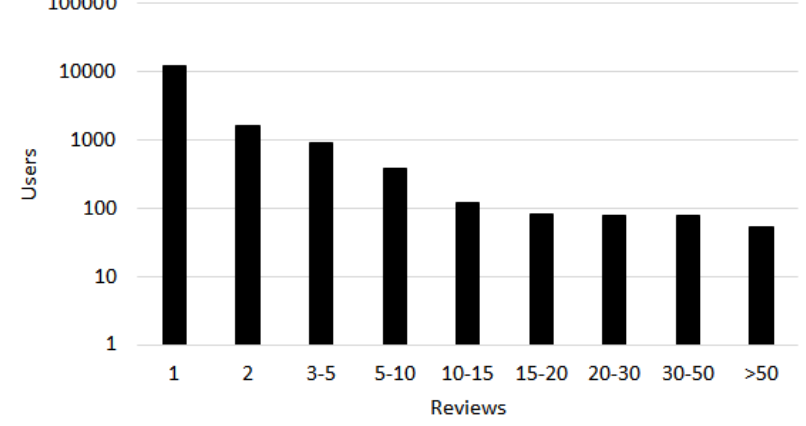
Fig. 1. A histogram in log scale of the number of reviews per user for the escape-rooms dataset.